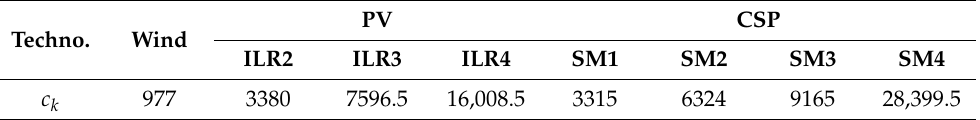
Table 4. The yearly rental cost c k (9) ( e /kW/yr) per production technology j or production tech- nology with its storage technology j , j (cid:48) calculated using Equations (10) and (11); and using storage